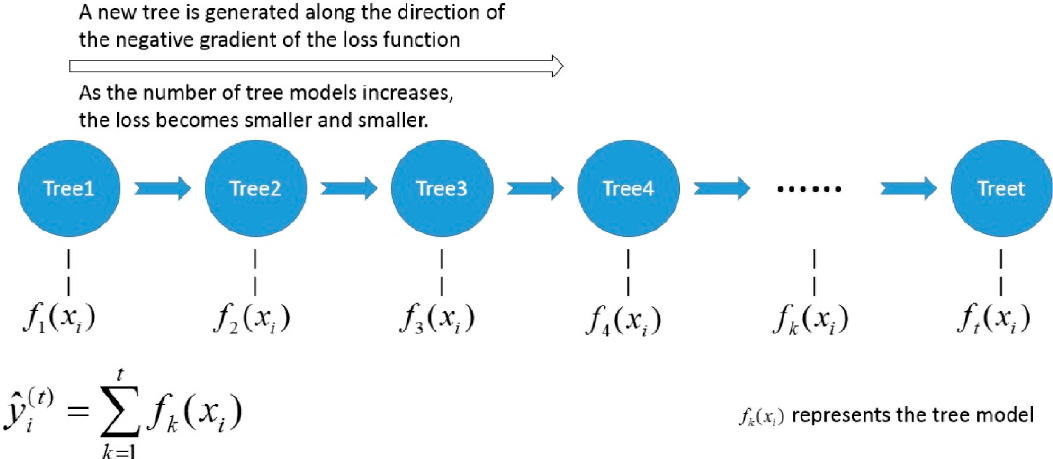
Figure 4. A schematic diagram of the XGBoost algorithm.